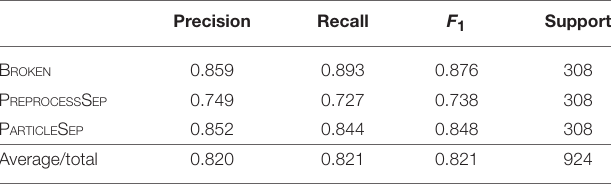
TABLE 1 | Performance metrics for the classifier based on the simulated test data. Precision